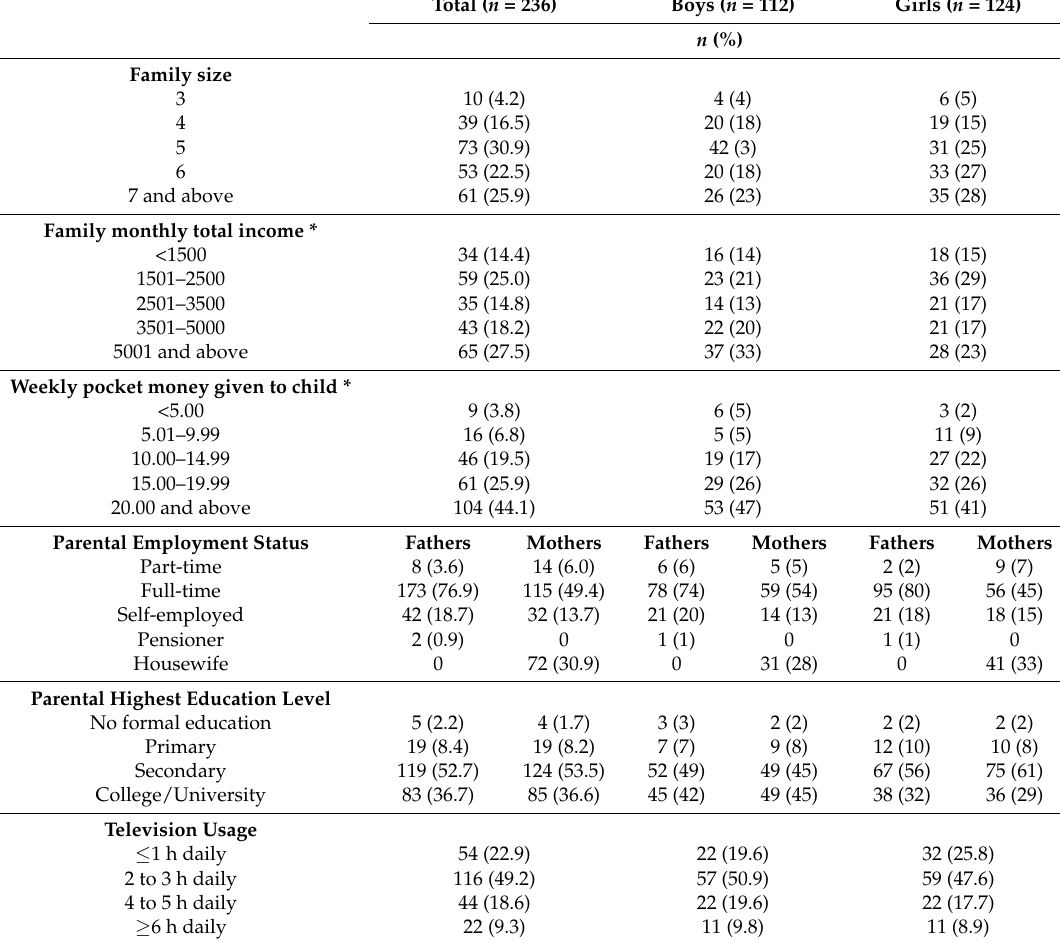
Table 1. Participant characteristics in The Family Diet